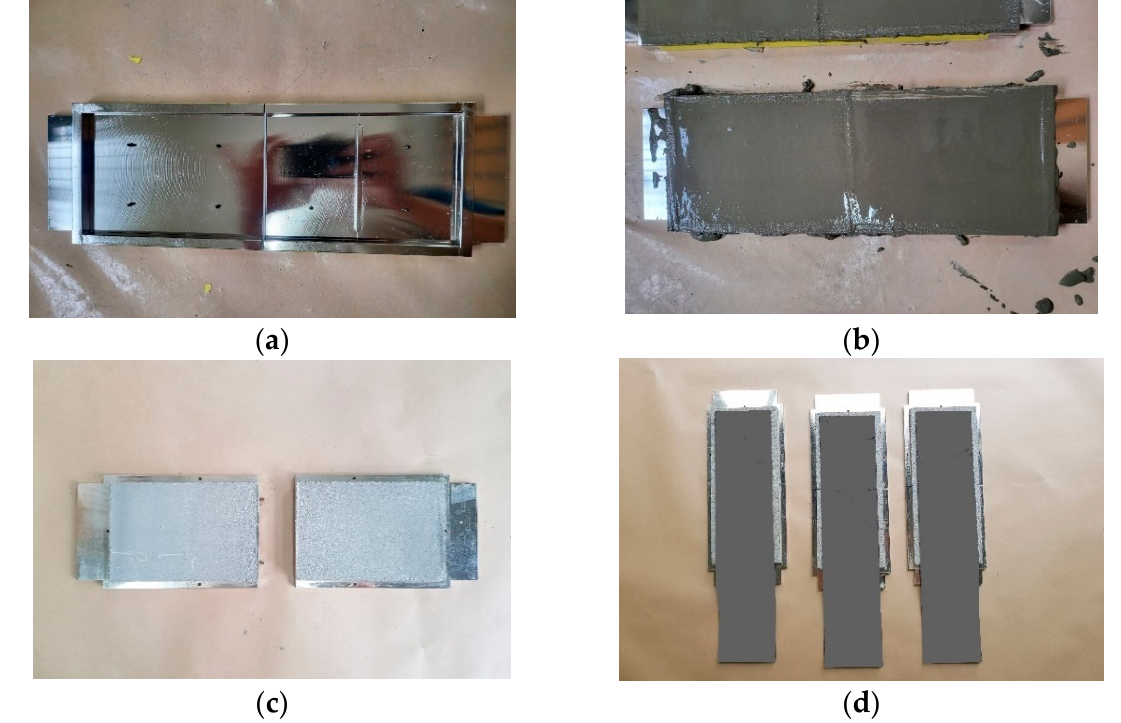
Table 2. The size of the mortar specimen and adhesion area for the viscoelastic strength test.